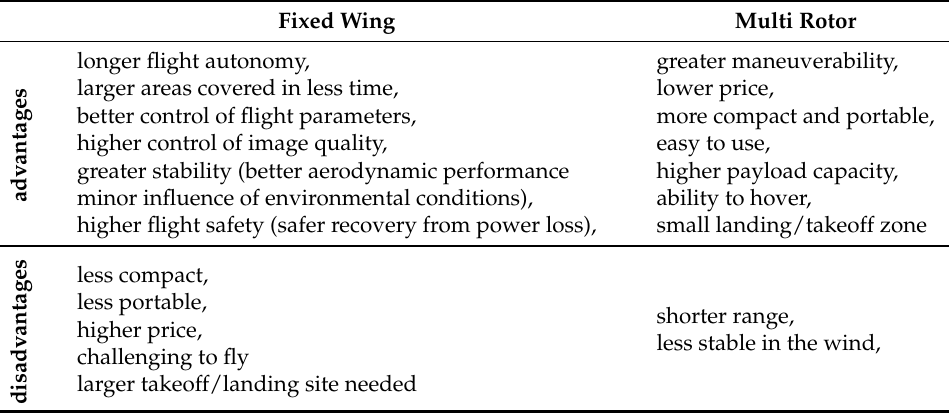
Table 2. Comparison between different features of fixed-wing and multi-rotor UAS. Fixed